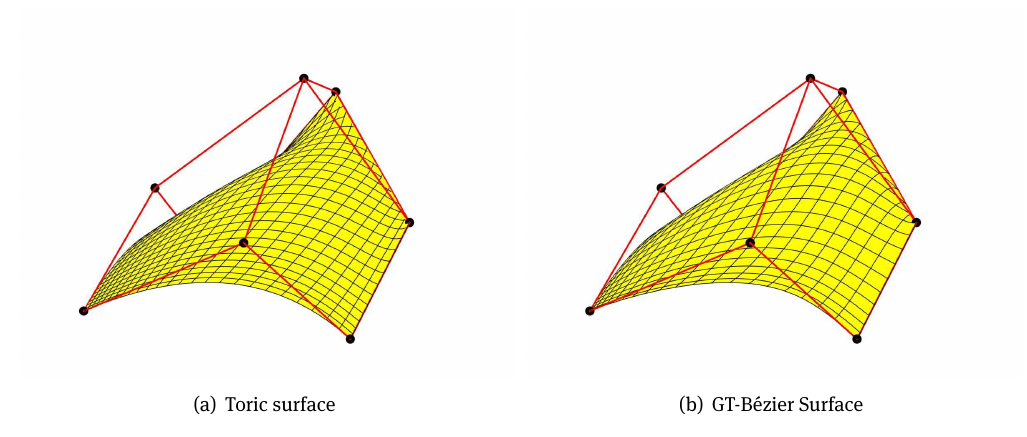
Figure 13: Toric Surface and GT-Bézier